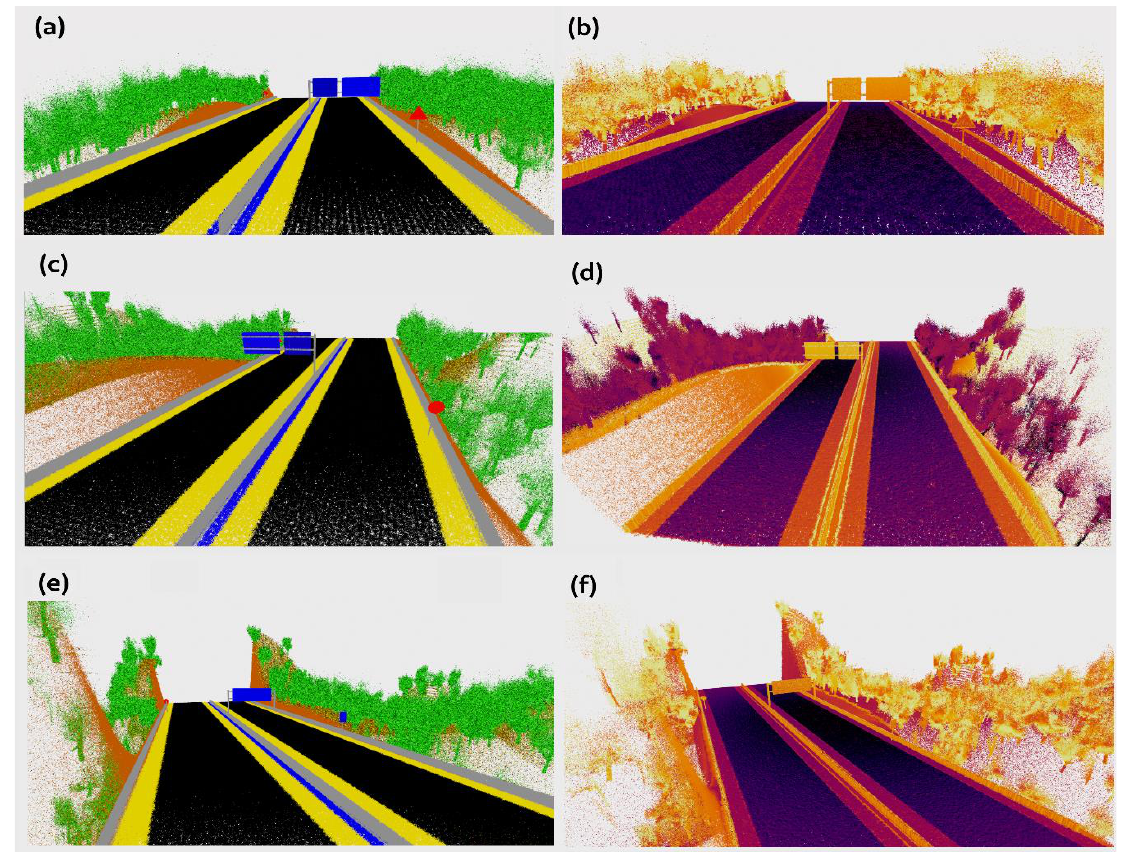
Figure 5. Views of different highway point clouds colored by labels (a ,c ,e) and colored by Pr/C values at a laser wavelength of 900 nm (b, d, f).